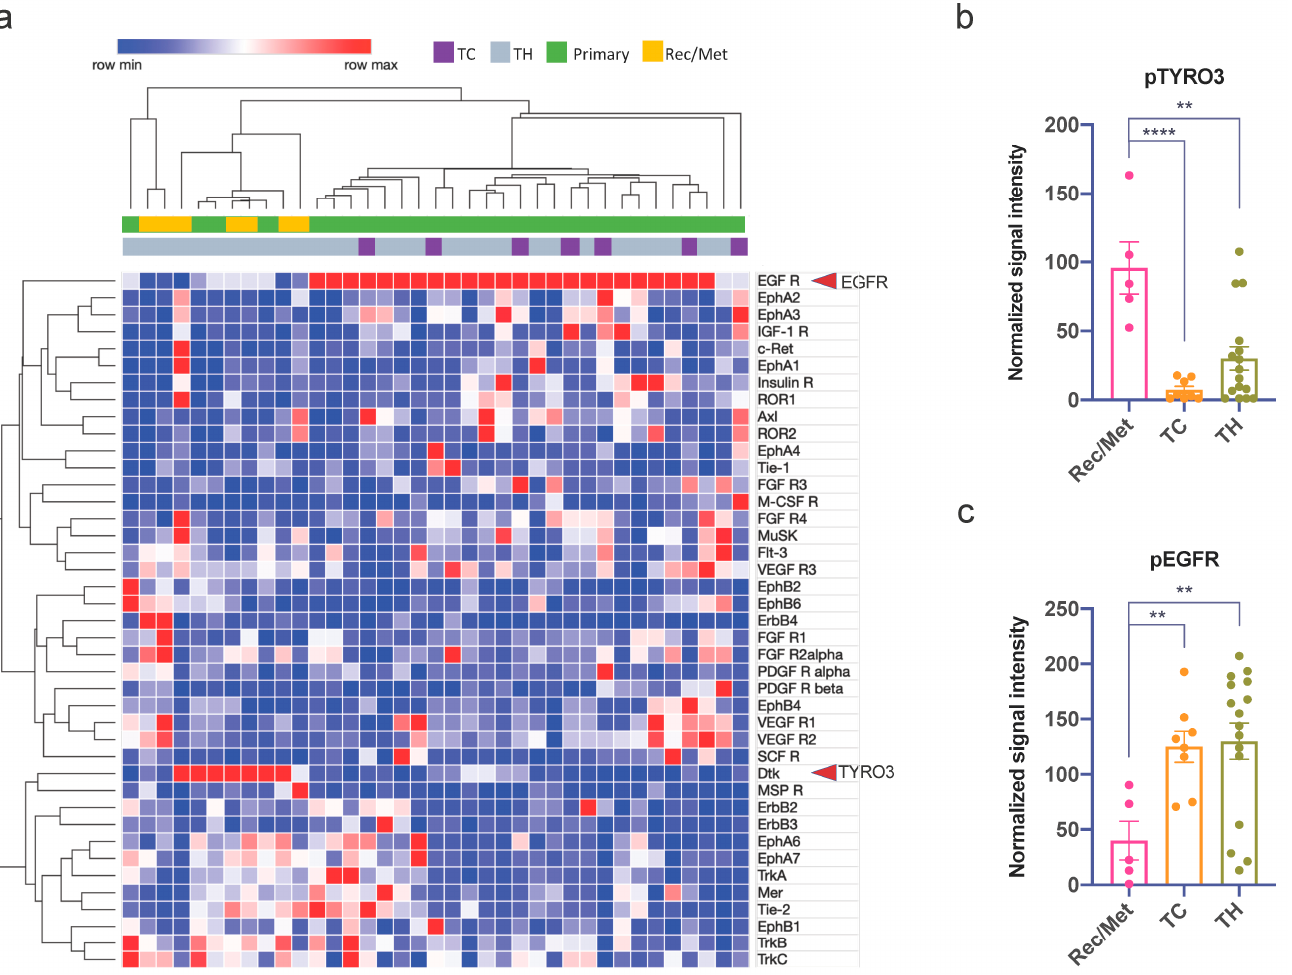
Figure 3. RTK activity array reveals EGFR and TYRO3/Dtk as the main targets in TET. ( a ) Heatmap of normalized RTK array dot plot signal values of 32 TH and TC shows non-overlapping signals for EGFR and TYRO3/Dtk (arrows). Metastatic TH (MET) and recurrent TH (Rec) are mainly found in the TYRO3/Dtk cluster. ( b ) Average TYRO3 signal was significantly higher in Rec/Met than in primary TH and TC. ( c ) In contrast, EGFR activation was significantly higher in primary/localized TH and TC than in Rec/Met (** p < 0.01, **** p < 0.0001).